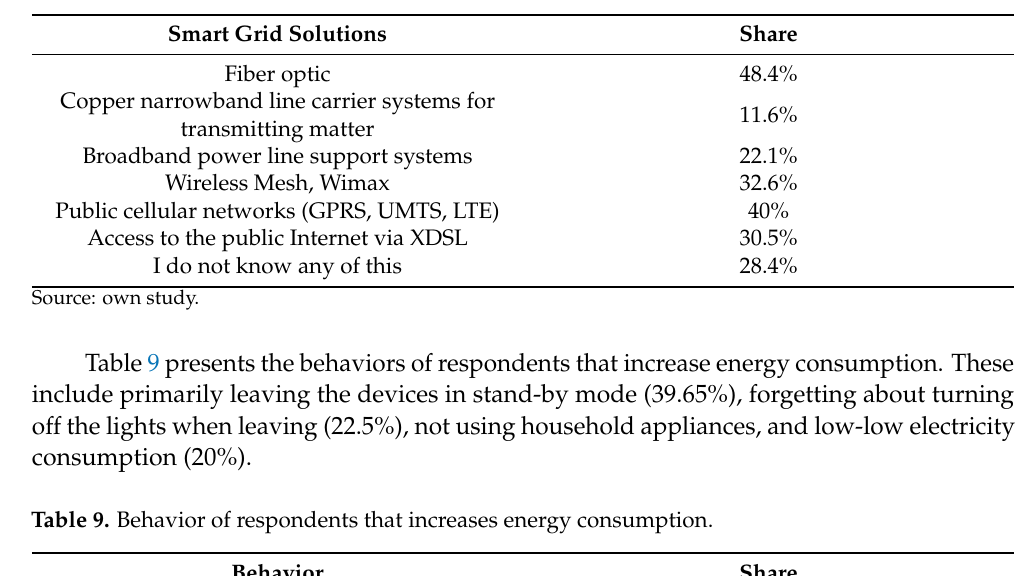
Table 8. Smart grid solutions known to respondents.